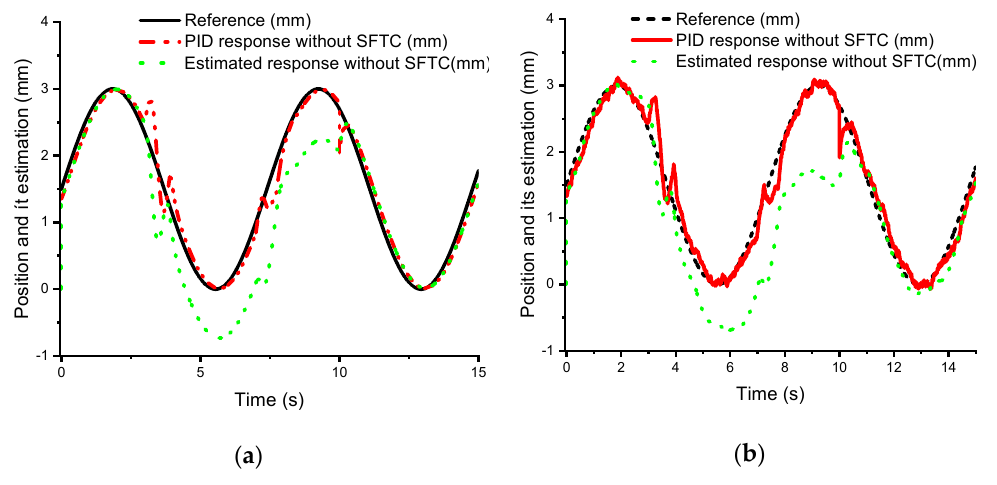
Figure 3. Position response and its estimation without SFTC of ( a ) disturbance d k = 0, and ( b ) disturbance d k = 0.0045 random (2, t ).